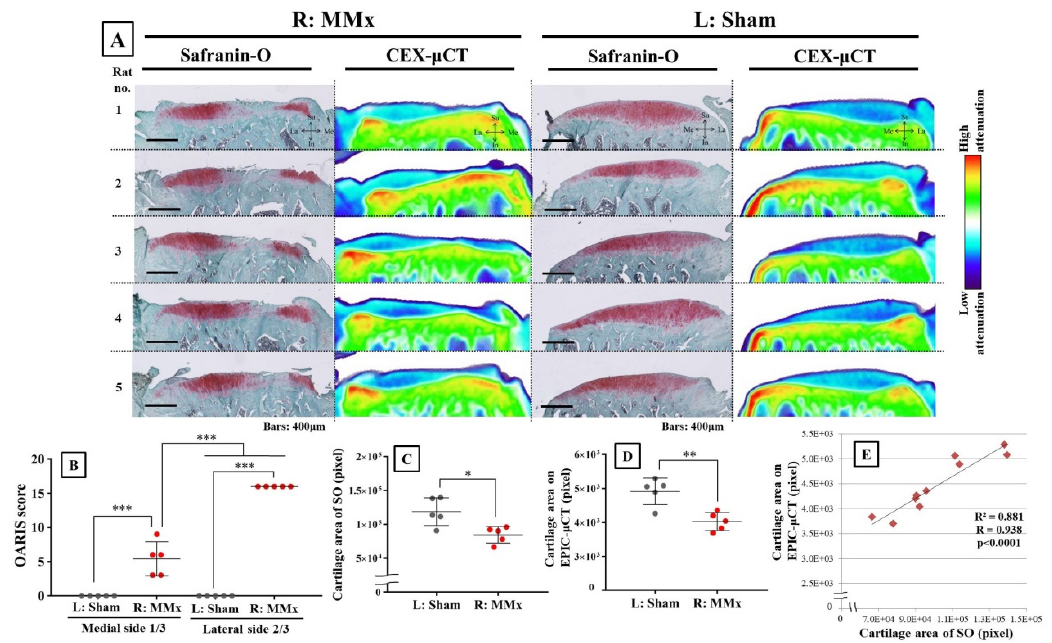
Figure 5. Confirmed degradation of articular cartilage by both Safranin-O (SO) staining and CEX- µ CT imaging for all samples. ( A ) Comparison between Safranin-O staining and CEX- µ CT imaging of articular cartilage on the tibia medial plateau. Both methods show cartilage degradation with similar morphology. ( B ) Osteoarthritis Research Society International (OARSI) guideline scores for Safranin-O staining in both MMx-treated and sham-treated groups. ( C ) Cartilage area based on Safranin-O-positive staining for both MMx-treated and sham-treated groups. ( D ) Cartilage area (pixels) according to CEX- µ CT method for both MMx-treated and sham-treated groups. ( E ) Correction analysis of the cartilage area between both Safranin-O staining and CEX- µ CT imaging methods. * p < 0.05, ** p < 0.01, *** p < 0.001.